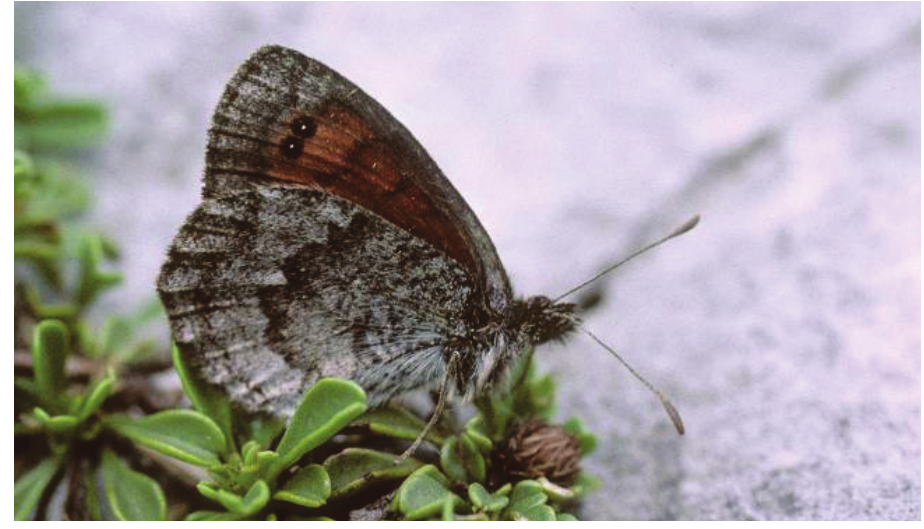
Erebia calcaria . Photo Tom Nygaard